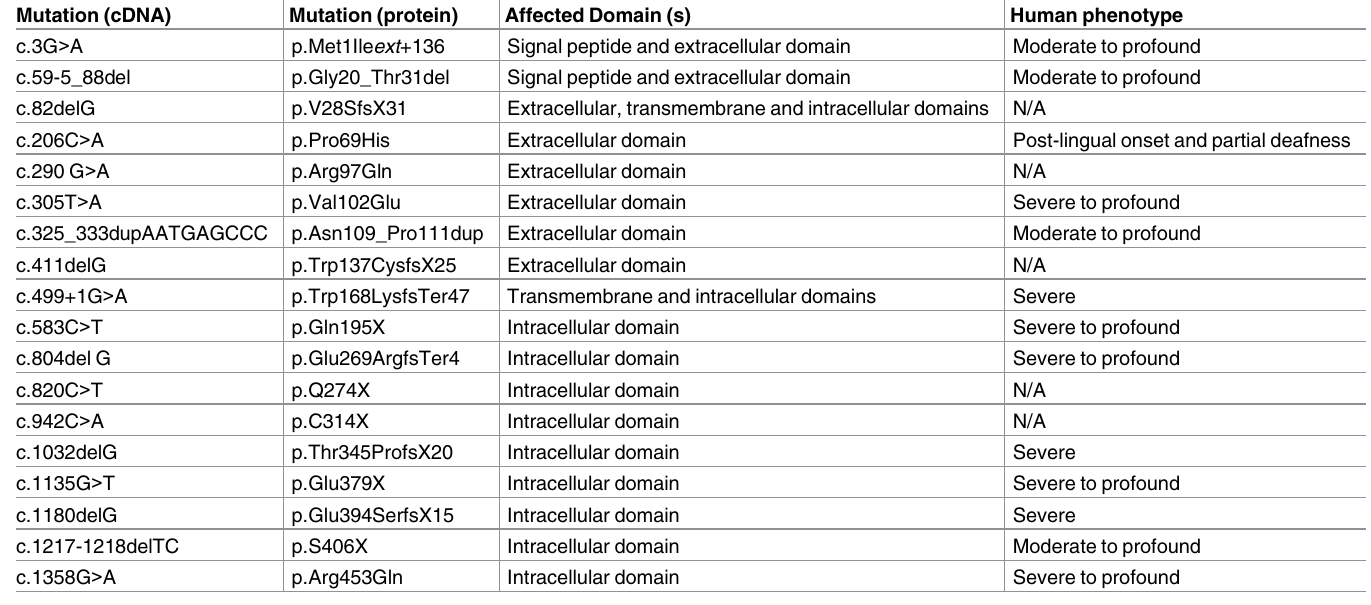
Table 2. Mutations in ILDR1 gene and